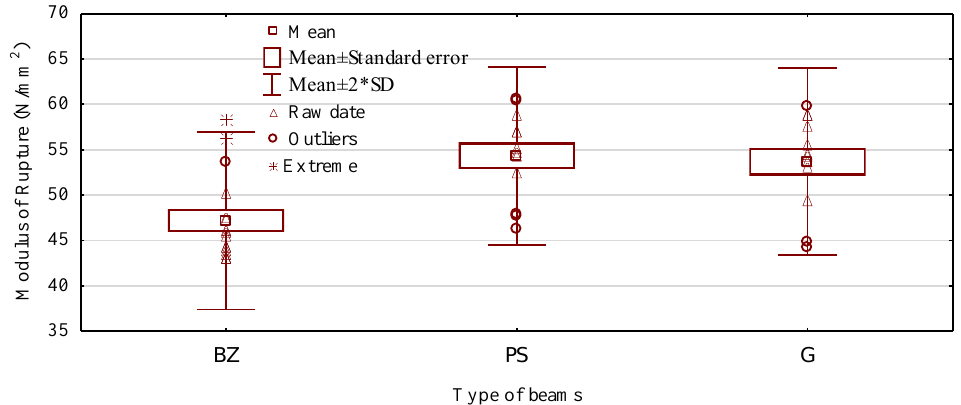
Figure 10. Characteristic values of static bending strength for manufactured beams.